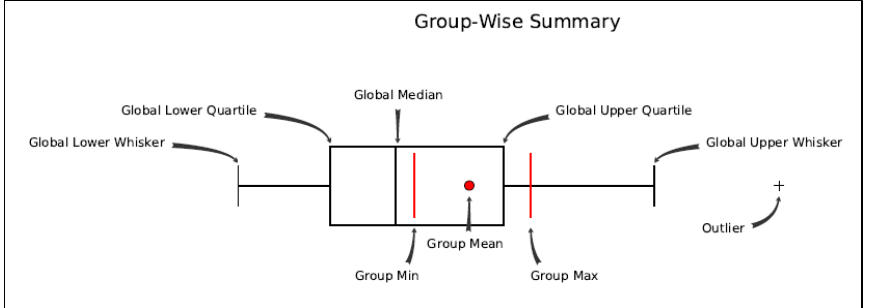
Figure 2. Methodological bloxplot. Source: GIS Methodology Esri.com, resulted with ArcMap 10.6.